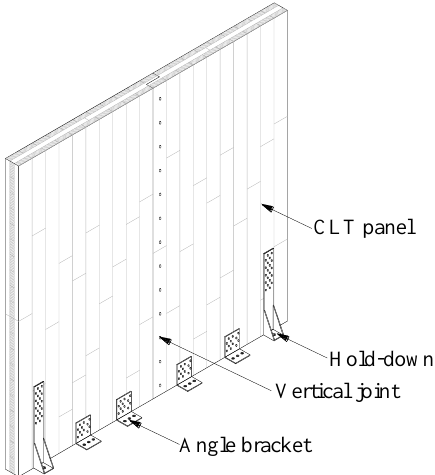
Figure 2. CLT shear wall connections (schematic produced by David Owolabi (UBC student, reprinted with permission)).